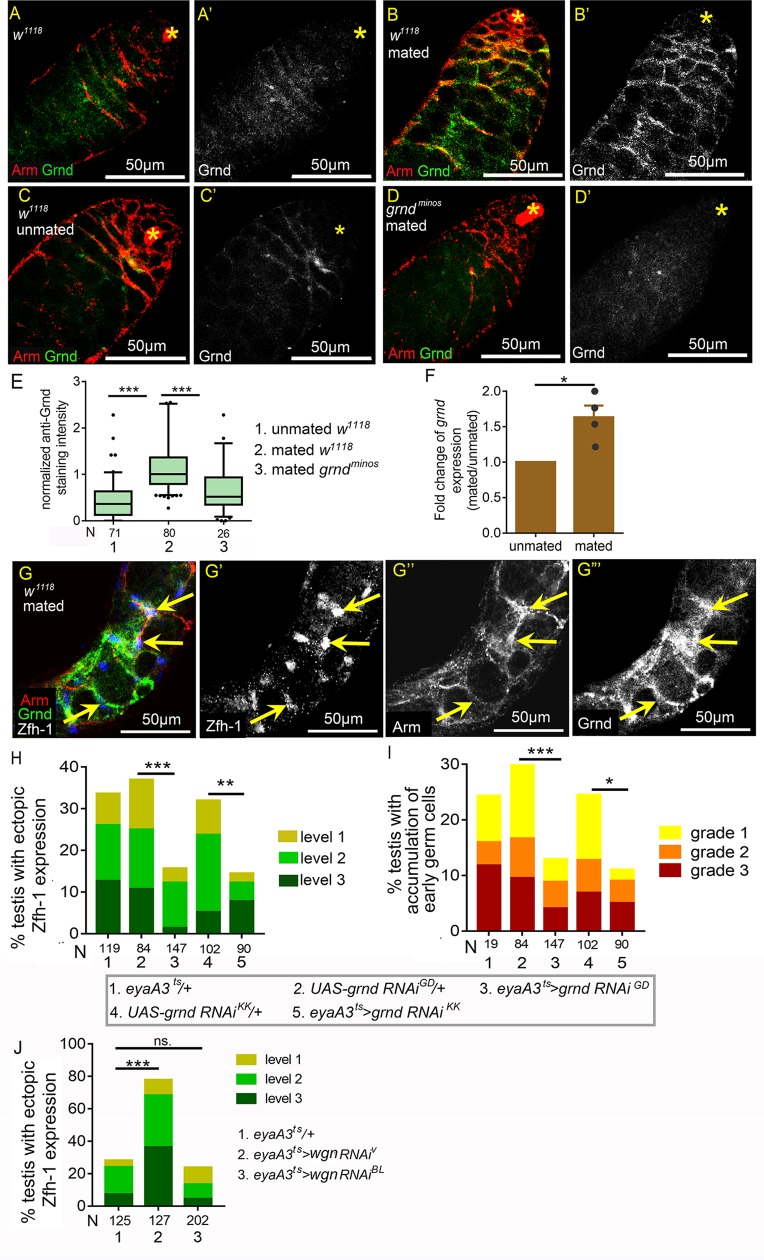
Expression of Grnd in cyst cells is elevated by reproduction.(A-D’) Testes immunostained for Grnd (green in A-D; white in A’-D’), co-stained for Arm (red in A-D). Asterisks mark the hubs. While there were almost no specific anti-Grnd signals in the testes from young males (1-3-day old) (A) and from 3w-old unmated males (C), Grnd was clearly detected in the cyst cell cytoplasm in testes of mated 3w-old males (B). Anti-Grnd signal was absent from the cyst cells in mated 3w-old grndminos testis (D). (E) Box-and-whisker plots showing normalized anti-Grnd/anti-Arm intensity in cyst cells. All the relative anti-Grnd intensities were further normalized to the median value for the testes of 3w-old mated males. (F) Fold changes of grnd transcript levels in testes from mated and unmated 3w-old males. Transcript levels were measured by qRT-PCR. The mean grnd/rp49 levels in different samples were normalized to that in the unmated testes. N (biological repeat) = 4. Error bars represent SEM. (G-G”‘) A testis with level-1 ectopic Zfh-1 phenotype from mated 5w-old w1118 male immunostained for Grnd (green in G, and white in G”‘), co-stained for Zfh-1 (blue in G; white in G’) and Arm (red in G; white in G”). Arrows indicate the anti-Grnd signals in the ectopic Zfh-1-positive cells. (H and I) Suppression of reproduction-induced ectopic Zfh-1 expression (H) and expansion of early germ cells (I) in testes of mated 4w-old males by two independent grnd RNAi lines expressed via eyaA3ts at 29°C. (J) Knockdown of wgn in cyst cells failed to reduce ectopic Zfh-1 expression in the testes of mated males. Statistic significances were calculated with Mann-Whitney test (E), paired t test (F), and Chi-squared test (H-I). *p<0.05, **p<0.01, and ***p<0.001. Mass-mating scheme were conducted for all experiments.